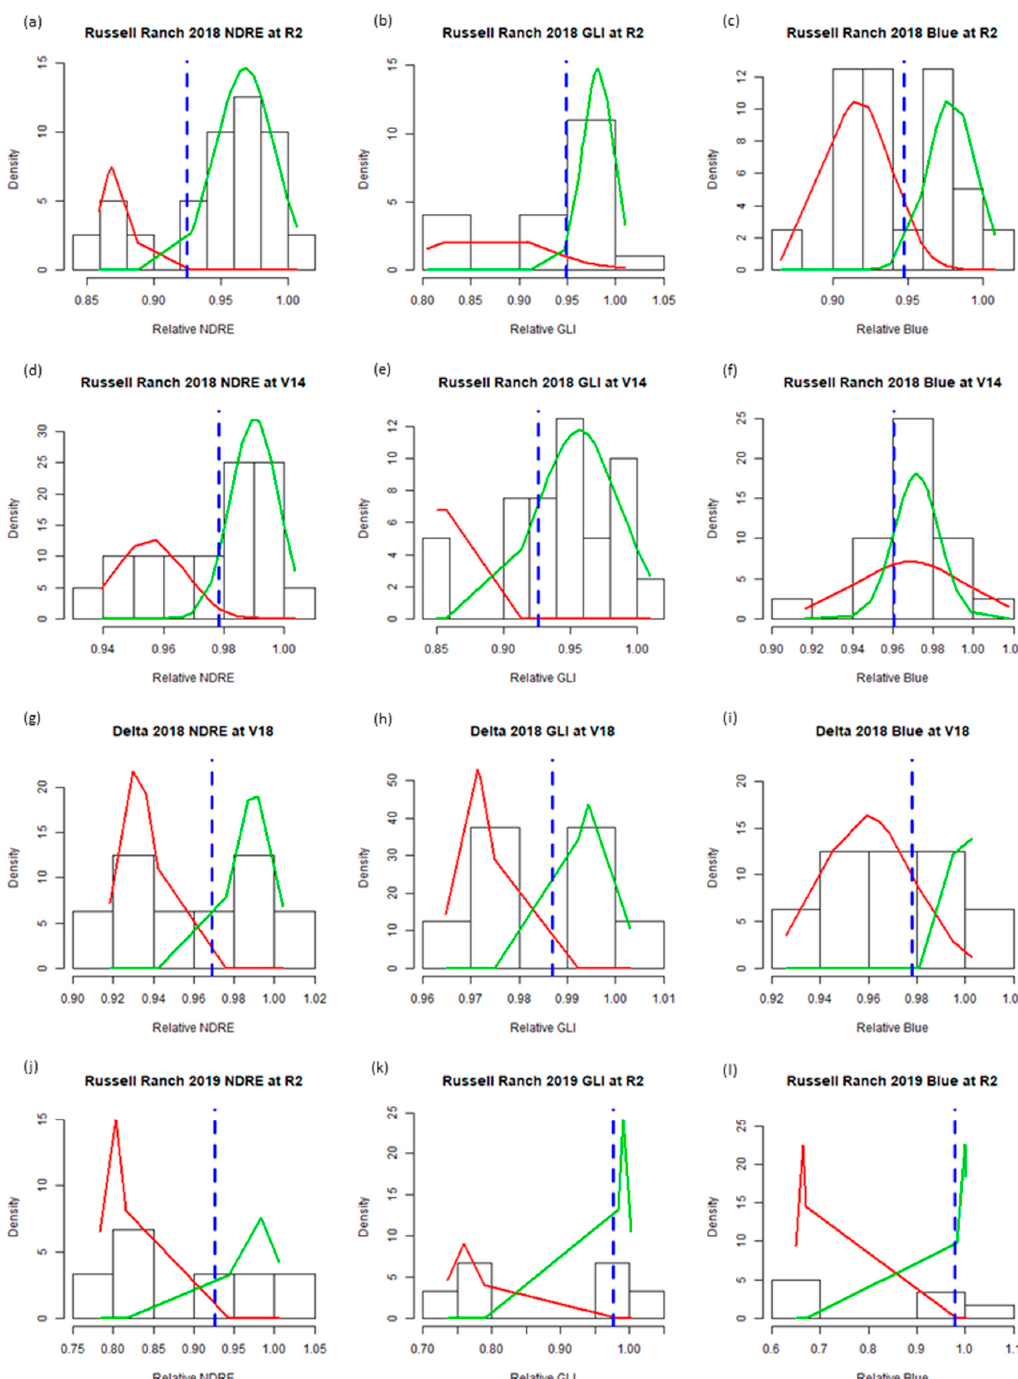
Figure A1. Density plot results from Gaussian mixture modeling analysis of the normalized difference red-edge (NDRE), green leaf index (GLI), and blue reflectance values for ( a – c ) the experimental site at blister (R2) and ( d – f ) the 14th leaf stage (V14), ( g – i ) validation site 1 at the 18th leaf stage (V18), and ( j – l ) validation site 2 at R2. Red and green curves show the modeled distribution of data split into each group by mixture modeling. The blue dotted line shows the thresholds used to split data into the two groups, with data below the threshold but in the “low” group and data above the threshold put into the “high” group.